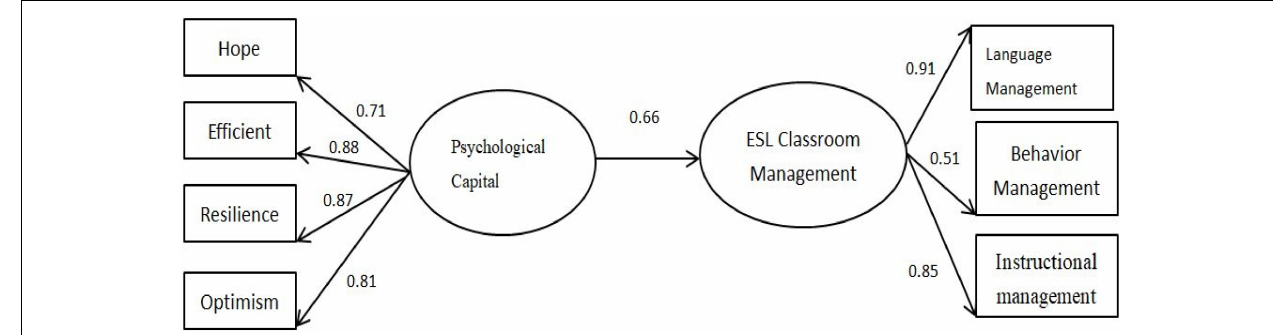
FIGURE 2 | Structural model of the relationship between PsyCap and ESL classroom management.